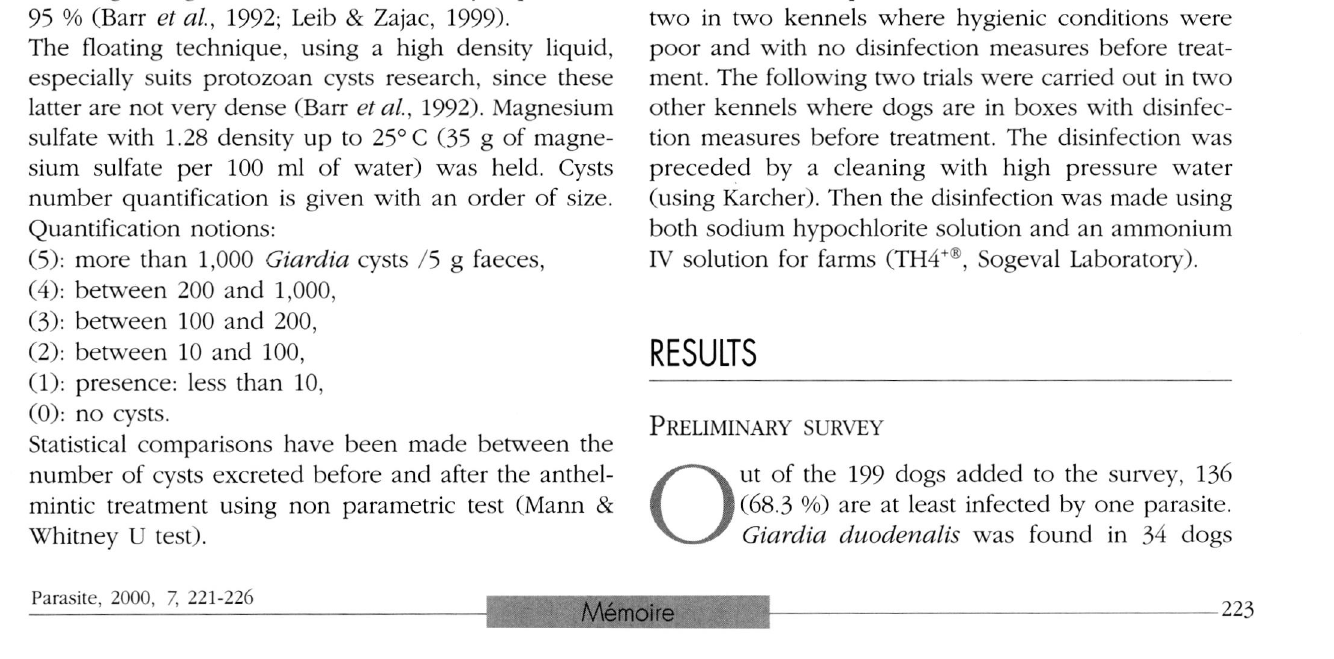
Statistical comparisons have been made between the number of cysts excreted before and after the anthel mintic treatment using non parametric test (Mann & Whitney U